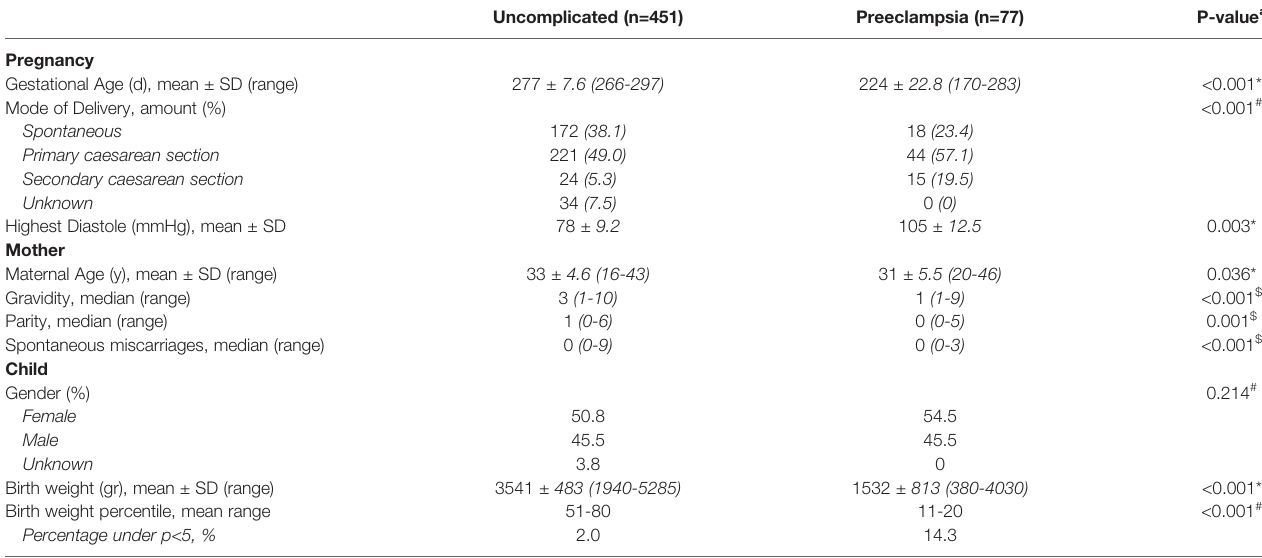
TABLE 1 | Baseline Characteristics.